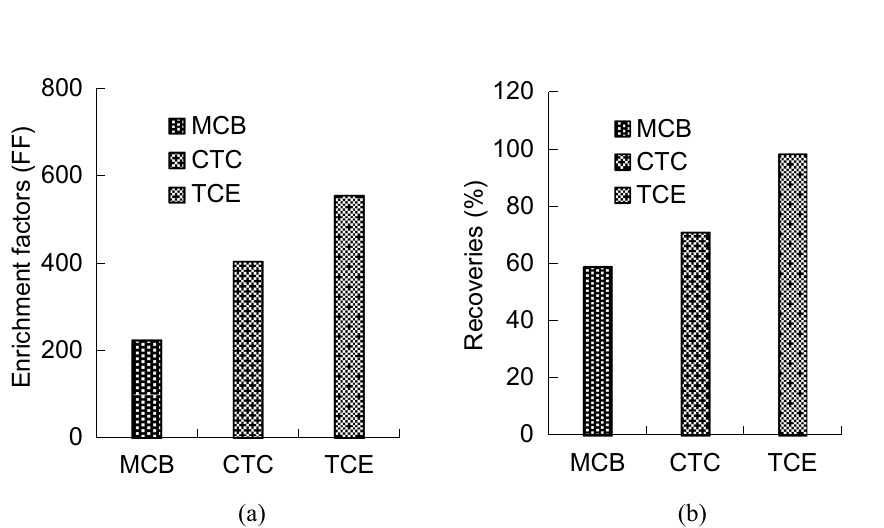
Figure 3. Different type of extraction solvent, ( a ) Enrichment factors of different type of extraction solvent, ( b ) Recoveries of different type of extraction